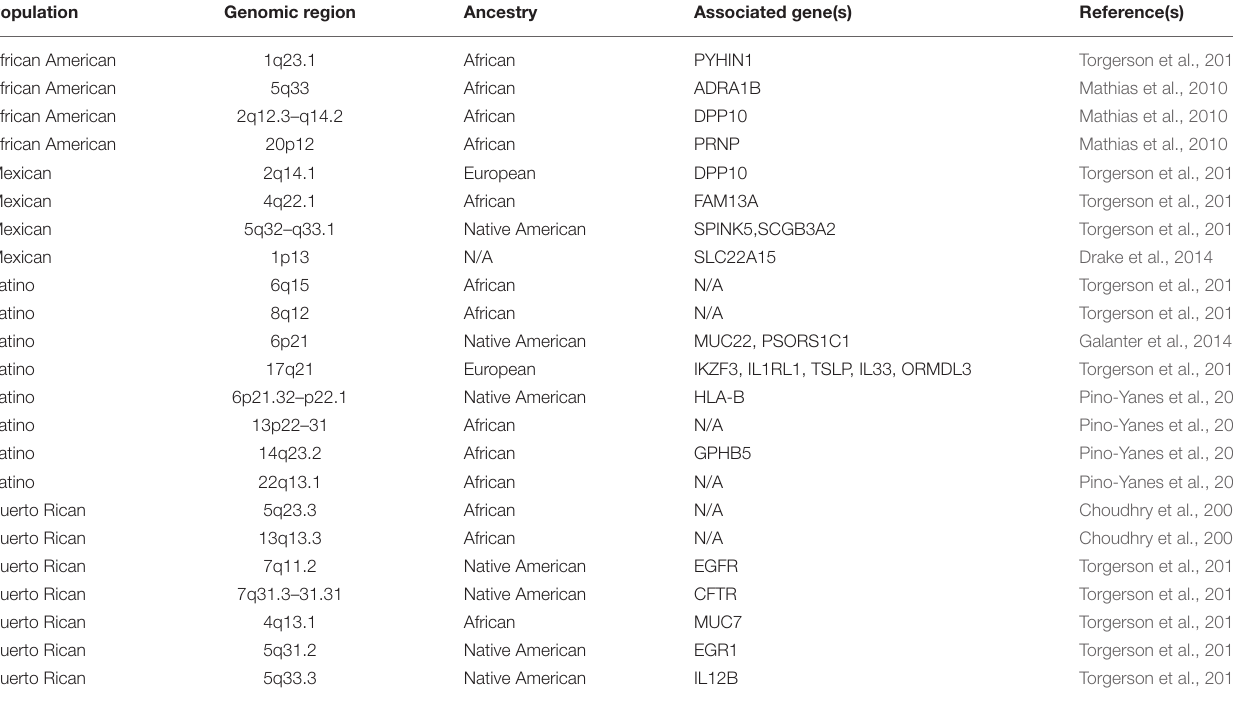
TABLE 1 | Admixture peaks containing ancestry-specific asthma susceptible genes identified by admixture mapping (AM). Population Genomic region Ancestry Associated